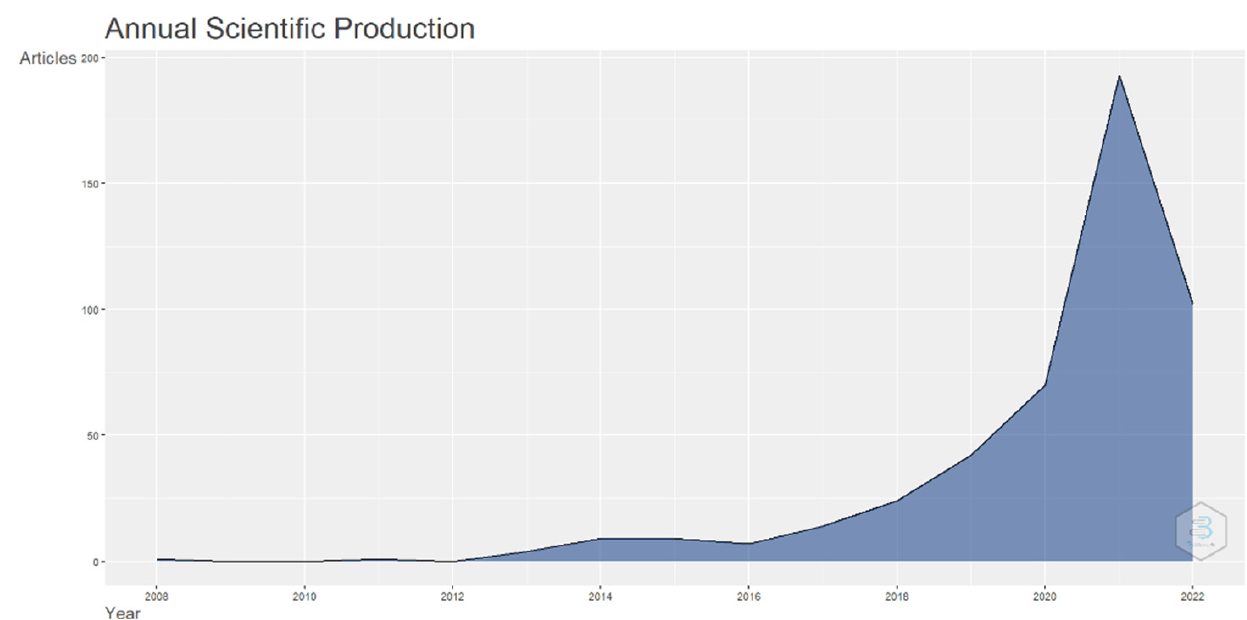
Figure 2. Annual scientific production of publications in ambidexterity and agility in SMEs. Source: Scopus/Biblioshiny.